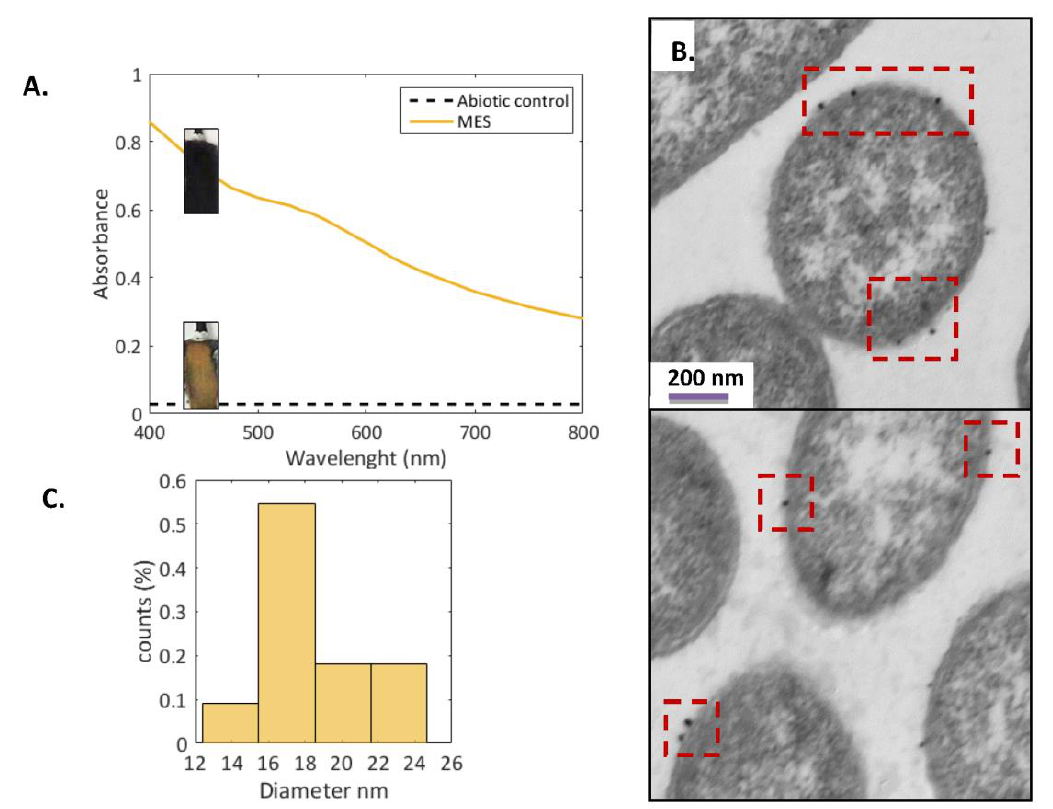
Figure 4. Confirmation of gold nanoparticle synthesis (AuNPs) in an electrochemical system with cathode potential fixed at − 0.3 V vs. SHE. ( A ) UV-Vis absorbance of non-filtered catholyte of BES compared with the abiotic control; ( B ) TEM of S. oneidensis MR-1 after 72 h of operation; ( C ) AuNPs size distribution from TEM micrograph.